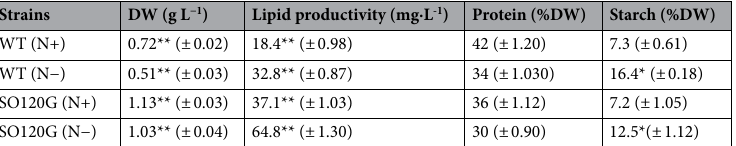
Table 1. The major biomass compositions of S. obliqnus . Values are means (± SD) of n = 3 cultivations per treatment, *represents a significant effect ( p < 0.05) and **represents a very significant effect ( p < 0.01).